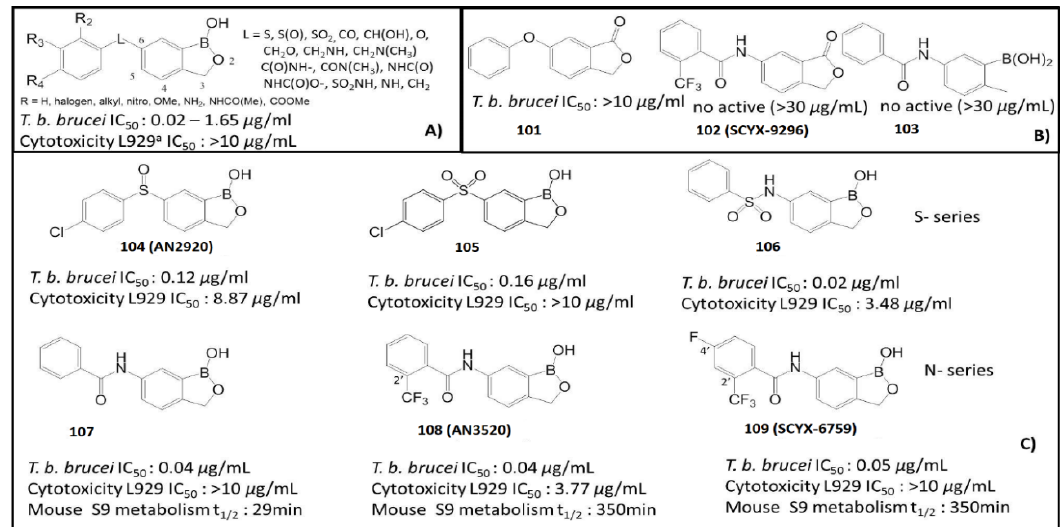
Figure 10. ( A ) Principal linker L in position C(6) of benzoxaboroles; ( B ) Structures and antitrypanosomal activity of no boron analogues 101 – 103 ; C ) Structures, antitrypanosomal activity, cytotoxicity and biological half-life t 1/2 of benzoxaborole derivatives S-series 104 – 106 and N-series 107 – 109 (Adapted from [94]).